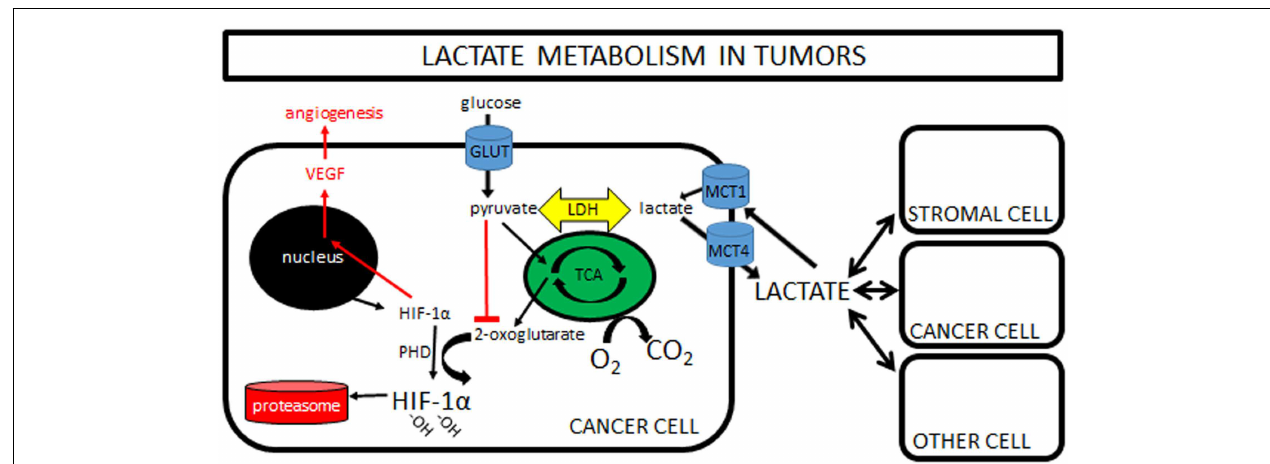
local and distant from the tumor. Note that the traditional “Warburg Effect” describes tumors relying heavily on glucose uptake (via GLUTs) with subsequent lactate exportation (via MCT4s) in normoxia. A “Reverse Warburg Effect” describes lactate production from stromal cells, which is then taken up and used by local cancer cells. Some unique combination of these pathways is likely present within each tumor, highlighting the need for further in vivo experimentation. (Note that MCTs can transport lactate either direction; MCT1s are typically expressed in cells importing lactate, while MCT4s are expressed in cells exporting